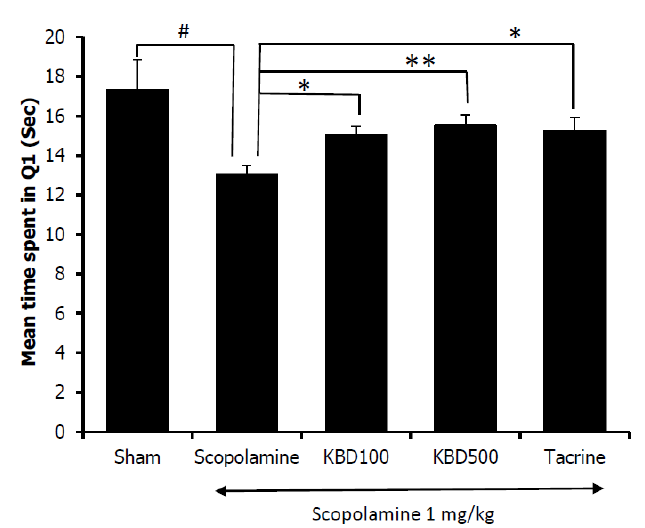
Figure 6. Effect of the KBD (100 and 500 mg/kg) on memory impairment induced by scopolamine in the water maze test. Tacrine at the dose of 10 mg/kg/day was used as a reference standard. The data were shown as mean ± SEM ( n = 8 – 10). # p < 0.05 versus control group (Sham), * p < 0.05 and ** p < 0.01 versus scopolamine-treated group.